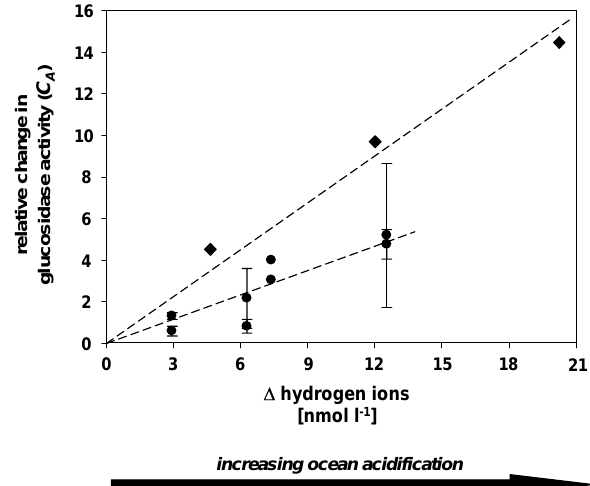
Fig. 3. Changing activity of extracellular glucosidases in response to rising hydrogen ion concentrations. Relative changes in glucosi- dase activity ( C A ) of natural bacterioplankton communities (cir- cles) and of Bacillus stearothermophilus (diamonds) were calcu- lated according to C A =( A FO − A PD ) / A PD , where A PD and A FO are the glucosidase activities at present-day and future-ocean pH, re- spectively. The increase in hydrogen ion concentration ( 1 hydrogen ions) induced by experimental acidification was calculated from the difference in pH between the present-day and the future-ocean treat- cell-specific glucosidase activity ment. Dashed lines represent linear regressions (marine glucosi- (present-day pH) dase activity: r 2 =0.80, p< 0.01; α -glucosidase B . stearothermophilus : r 2 =0.96, p< Figure 2 Fig. 2. Extracellular glucosidase activity at present-day and future- ocean pH. (a) Extracellular glucosidase activity in reference incuba- tions (open bars, PD: present-day pH) and at lowerd pH (solid bars, FO: future-ocean pH) in culture experiments and field assays. Glu- cosidase activity at future-ocean pH was significantly higher than at present-day pH (paired t -test, p< 0.01). Glucosidase rates of Cult- Exp I, CultExp II, FieldAssay I, and FieldAssay II were compiled for the statistical test. (b) Log-log plot of cell-specific α - and β - glucosidase activity (circles and triangles, respectively) at present- day versus future-ocean pH.